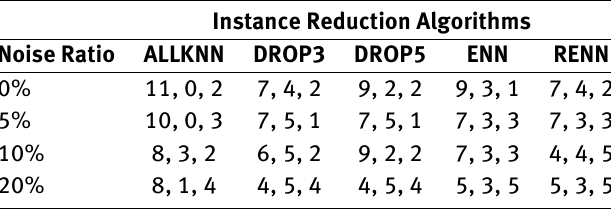
Table 17: Total Number of datasets with affected average Tree Size (++, unknown, –) for pruned trees at different noise ratios